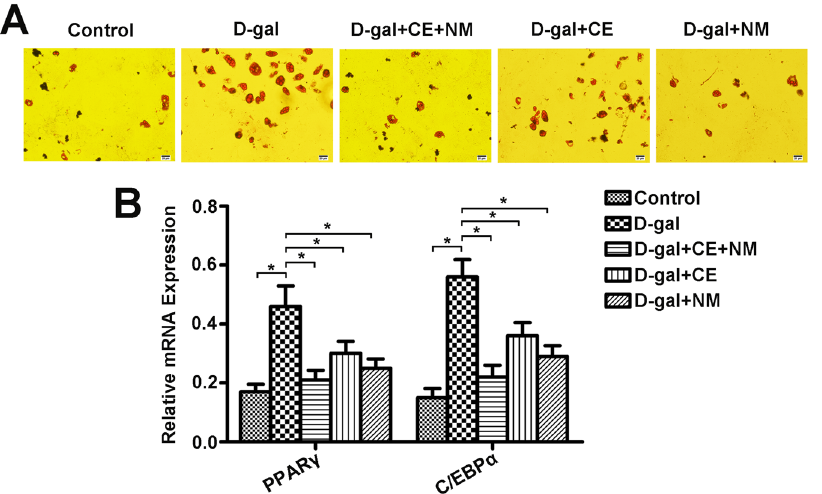
Figure 4. CE and NM supplement effect on the differentiation of BMSCs into adipocytes in aging rats. ( A ) Adipogenic differentiation of BMSCs in aging rats treated with CE and NM for 14 days was detected by Oil Red O staining. ( B ) The levels of PPAR γ and C/EBP α mRNA in BMSCs treated with CE and NM were measured by qRT-PCR. The expression of each target gene relative to that of GAPDH was calculated ( * P < 0.05). Values were mean ± SD of three independent